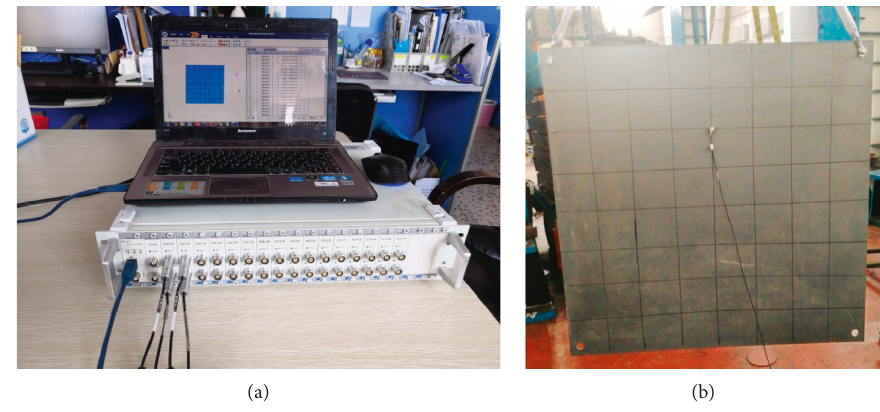
Figure 5: (a) Test system; (b) test model.